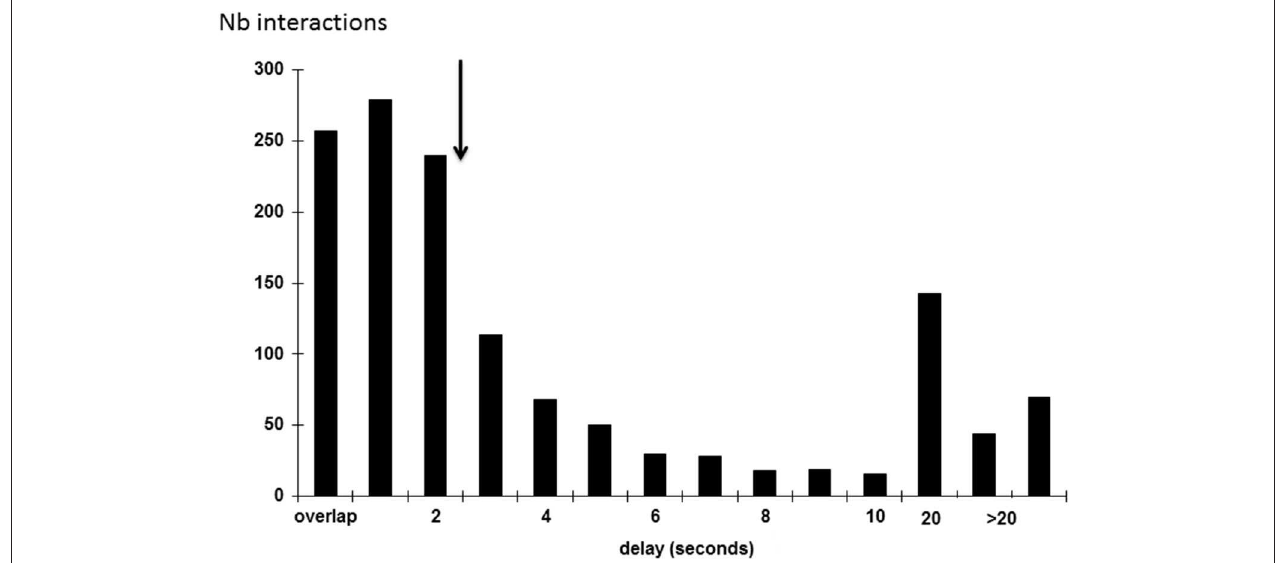
FIGURE 5 | Interval separating two successive whistles produced by two different individuals (overlap: when two whistles overlap). The arrow indicated a break in the interactions after a 2s delay.